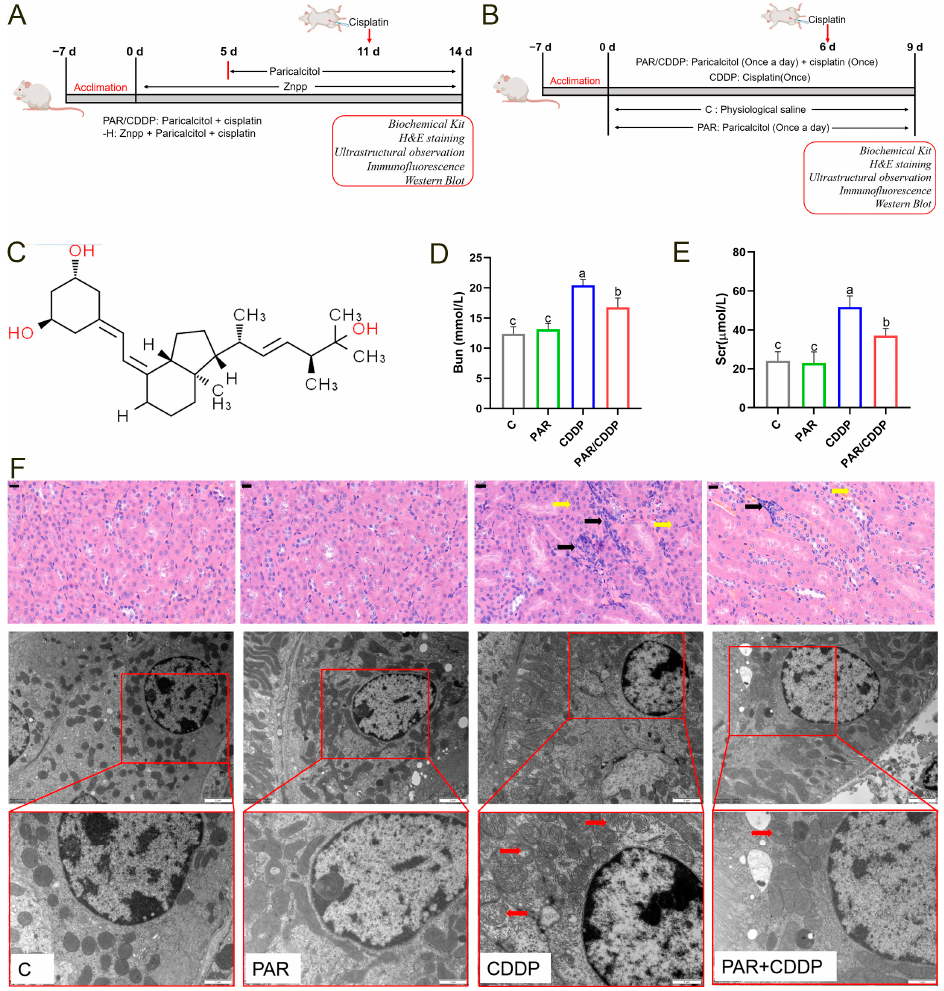
Figure 1. The effect of paricalcitol on cisplatin-induced AKI. ( A , B ) Schematic of the experiment. ( C ) Chemical structure formula of paricalcitol. ( D ) BUN level in mice blood ( n = 6). ( E ) SCr level in mice serum ( n = 6). ( F ) Histopathological examination (scale bars, 20 μ m) and transmission electron microscopic images (scale bars, 2 µ m and 1 µ m) of mice kidneys ( n = 3). Yellow arrow, renal tubule epithelium cells injury; Black arrow, inflammatory cell infiltration; Red arrow, mitochondrial damage. C, control group; PAR, paricalcitol group; CDDP, cisplatin group; PAR/CDDP, paricalcitol + cisplatin group. Bars that do not share the same letters are significantly different ( p < 0.05) from each other. Results are presented as Mean ± SD. Statistical significance was obtained by one-way